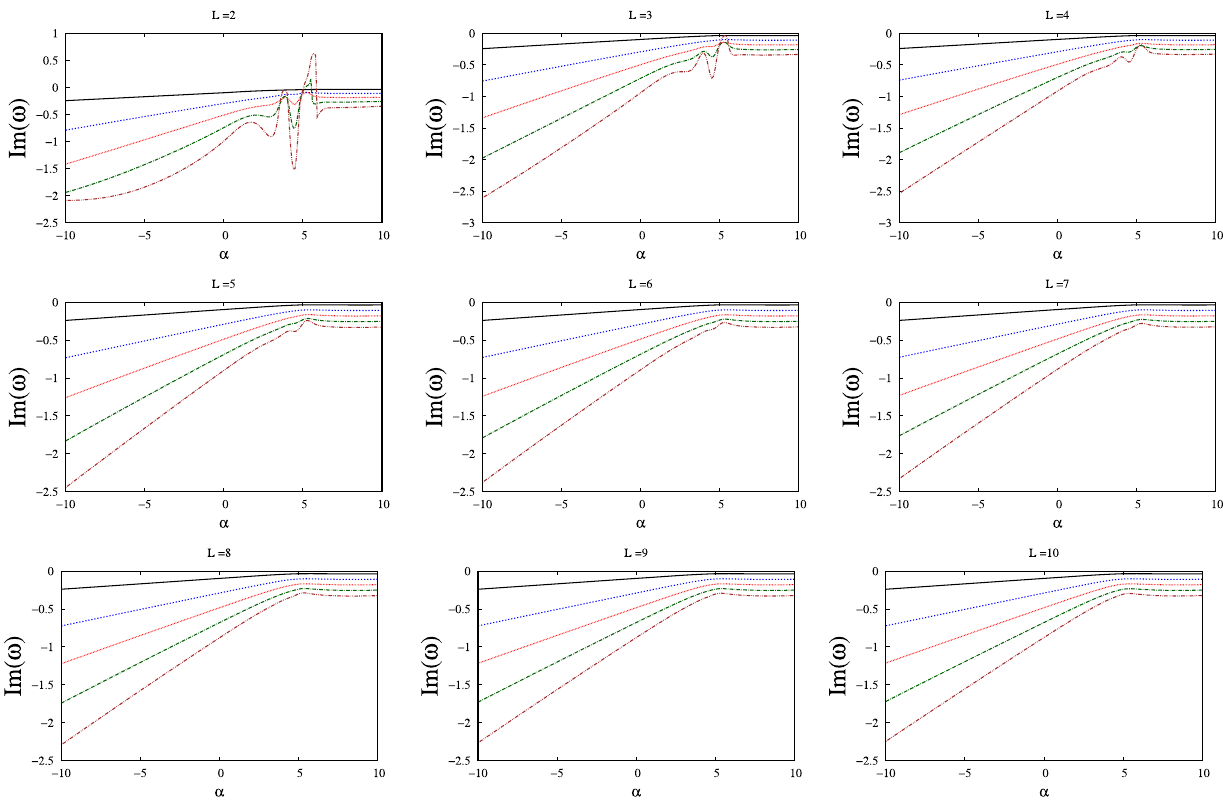
Fig. 2 Imaginary part of the QNM for Model 1 as a function of the hair α for different values of L and n . Each plot corresponds to a different value of L . The values for n are 0 (black line), 1 (blue line), 2 (red line), 3 (green line), 4 (brown